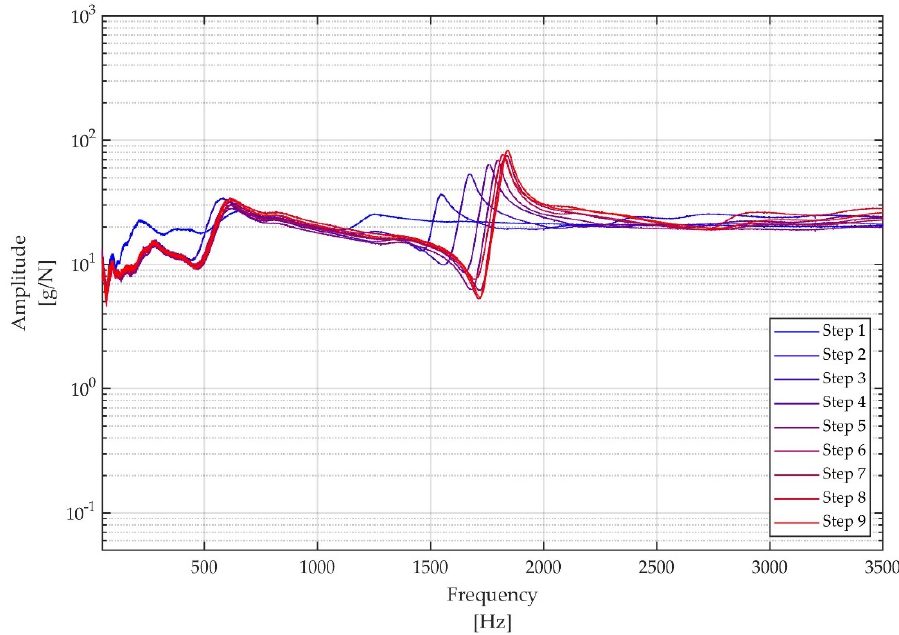
Figure 7. Comparison of FRFs corresponding to subsequent insertion steps with soft tissue in the AP